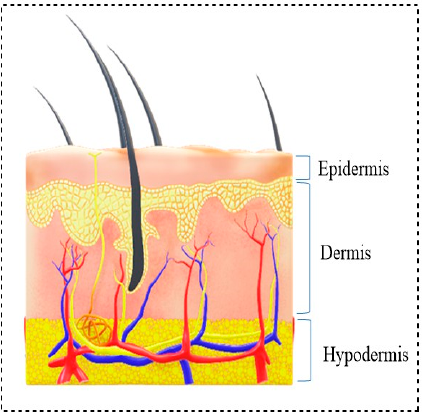
Figure 1. The cross-section view of human skin.